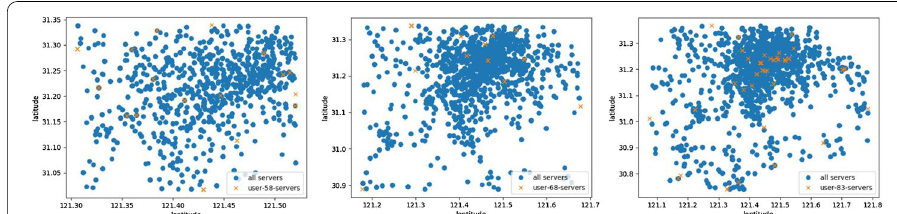
Fig. 6 Historical track point distribution and neighbor distribution for different users